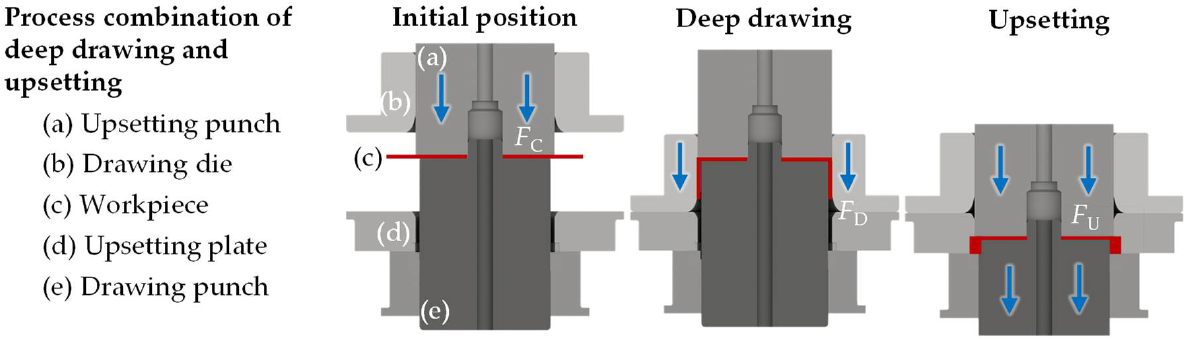
Figure 5. Schematic setup of the combined deep drawing and upsetting process [8].